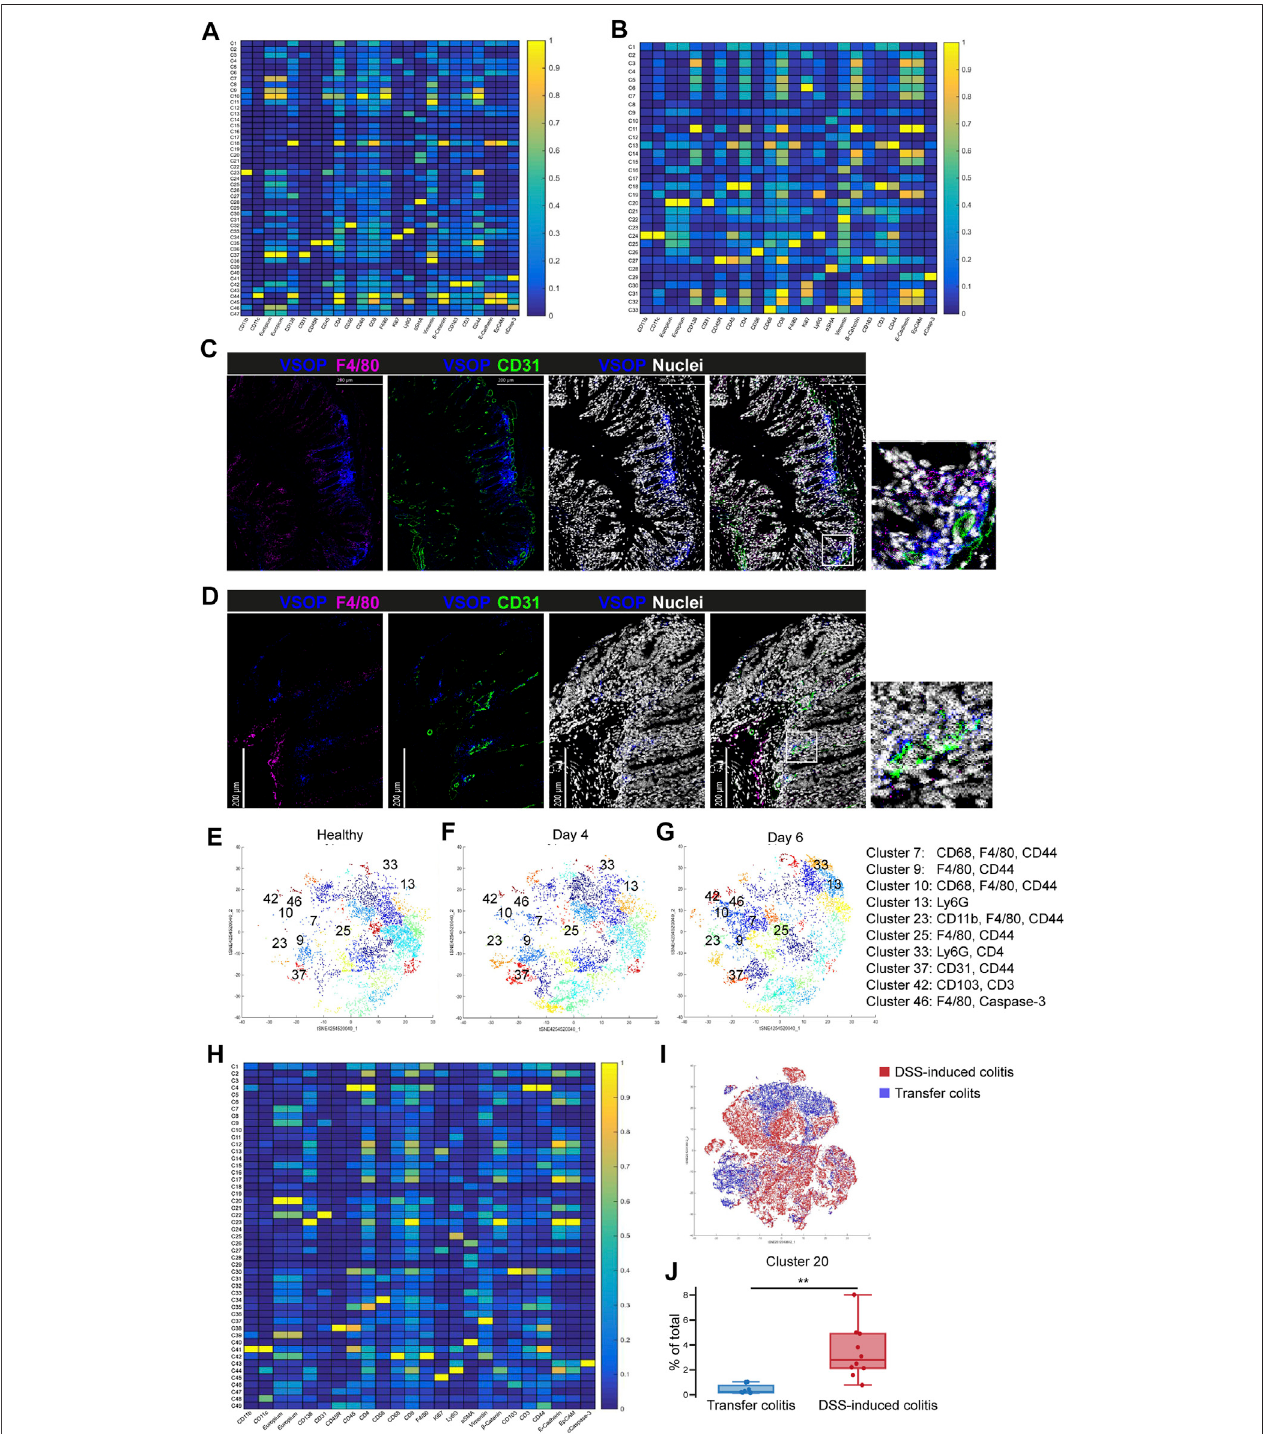
FIGURE 5 | VSOPs accumulate in vessels and macrophages in colon tissue of DSS-induced colitis mice and to a lower extent in transfer colitis mice. Heatmap summarizes computational analysis of colon tissue from mice with DSS-induced colitis. VSOPs accumulate within CD31 + endothelial cells as well as with CD45 + hematopoietic cells, speci fi cally with CD68 + , F4/80 + macrophages expressing CD44, CD3 + T cells expressing CD103 + , CD11b + macrophages in DSS-induced colitis (A) In transfer colitis, VSOPs most prominently cluster with CD31 + endothelial cells (cluster 20) and to lower extent with F4/80 + macrophages (cluster 25) and CD11b + , CD11c + and Ly6G + macrophages (cluster 24) (B) . Representative IMC images of a DSS-induced colitis mouse at day 6 (C) and a transfer colitis mouse at day 40 (D) injected withVSOPs, withF4/80inmagenta,CD31ingreen, VSOPs inblue andnucleiin white.PhenographclusteringofDSS-inducedcolitiscolonsampleswith